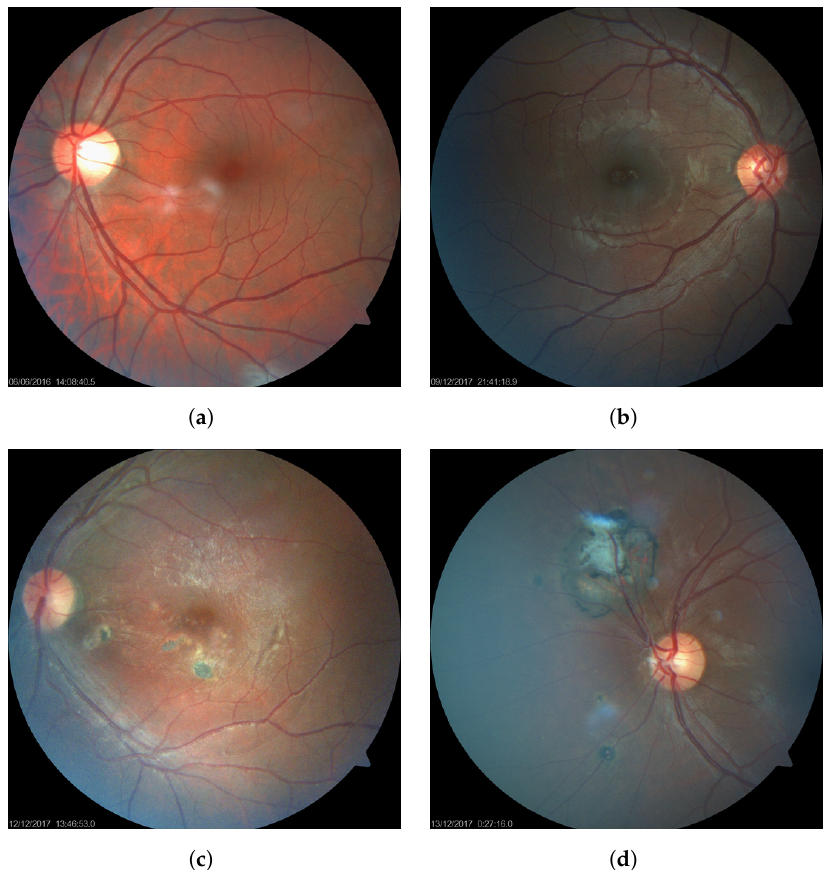
Figure 1. A sample of healthy ( a , b ) and unhealthy ( c , d ) retinal fundus images from the dataset. Images were captured using a Zeiss brand camera, model Visucam 500, operated by experienced ophthalmologists. Each image was manually segmented by an ophthalmol- ogist using an open source labeling tool (https://labelstud.io (accessed on Wednesday, 20 October 2021)) to manually highlight OT entities (active lesions and inactive scars). Active lesions have variable size, white or yellow color, blurry edges and a cottony center. They might be associated with a brown retinal hyperpigmentation area,